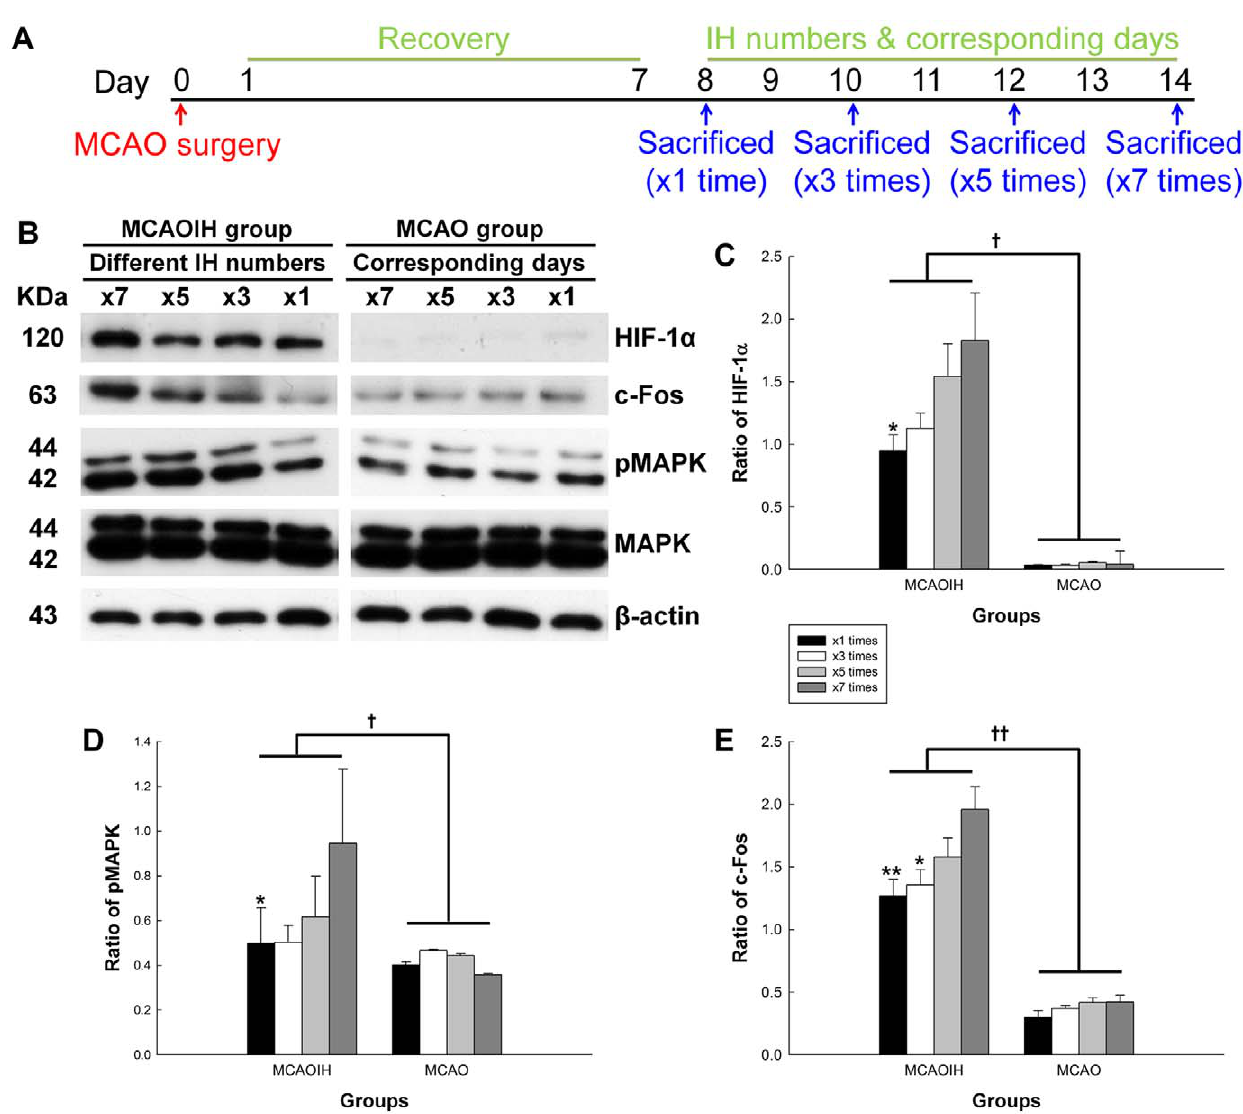
Figure 6. Hippocampal HIF-1 a , c-Fos, and pMAPK expression increased gradually with increasing numbers of post-ischemia IH interventions. (A) Experimental design. Ischemic rats were exposed to differing numbers (1, 3, 5, or 7) of IH interventions or sham IH sessions. (B) Immunoblotting was used to detect hippocampal HIF-1 a , pMAPK, MAPK, and c-Fos expression. (C–E) Quantification of immunoblotting results. * p , 0.05, ** p , 0.01, compared to the MCAOIH 6 7 group. { p , 0.05, {{ p , 0.01, compared to the MCAO group.